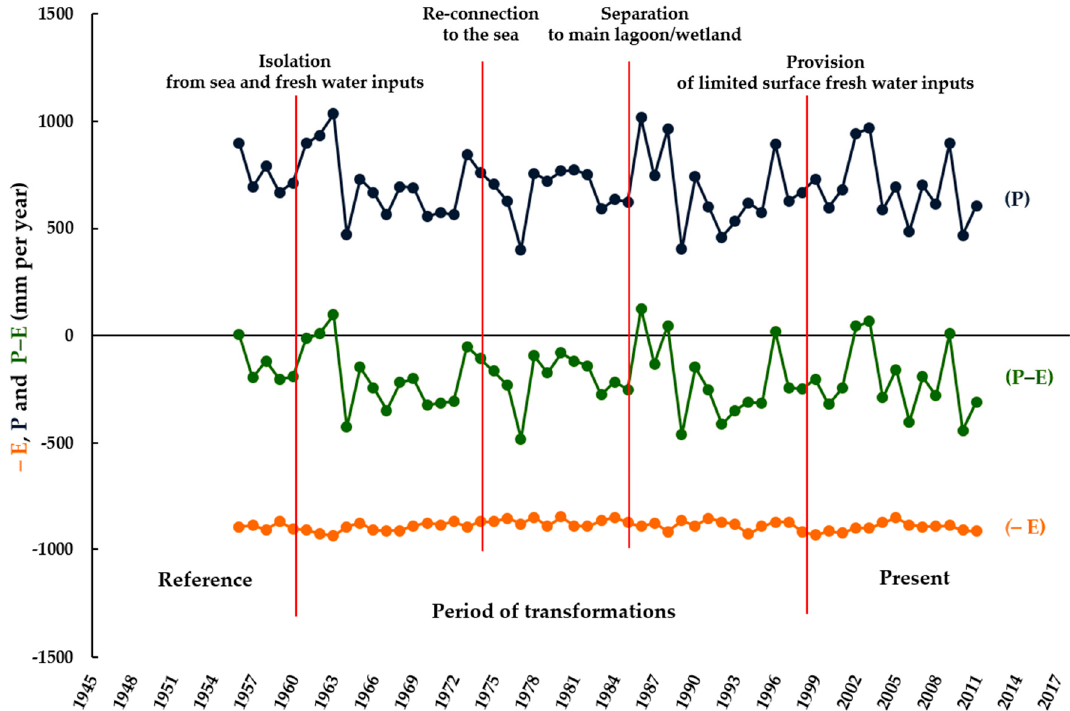
Figure 7. Annual water balance (mm/year) during the study period and major human interventions affecting surface water exchanges.